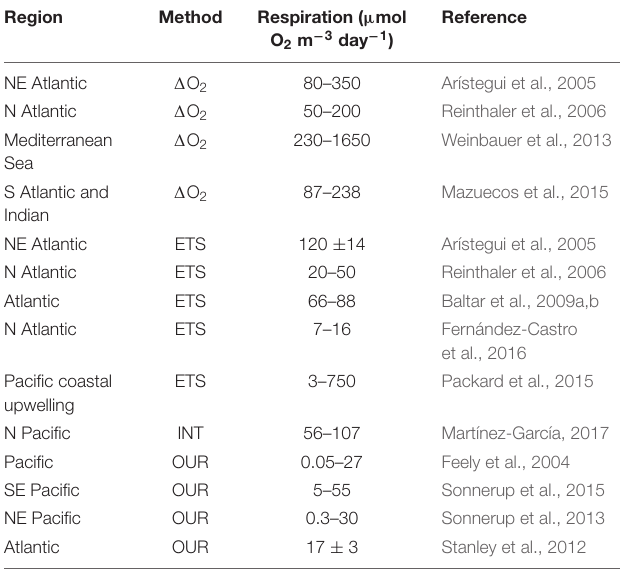
TABLE 1 | Recent midwater (100–1000 m) respiration estimates derived from dissolved oxygen consumption during a bottle incubation ( (cid:49) O 2 ), activity of the electron transport system (ETS), the reduction of the tetrazolium salt (INT), or the time resolved estimate of the amount of dissolved oxygen consumed since a water parcel was last in contact with the atmosphere, the oxygen utilization rate